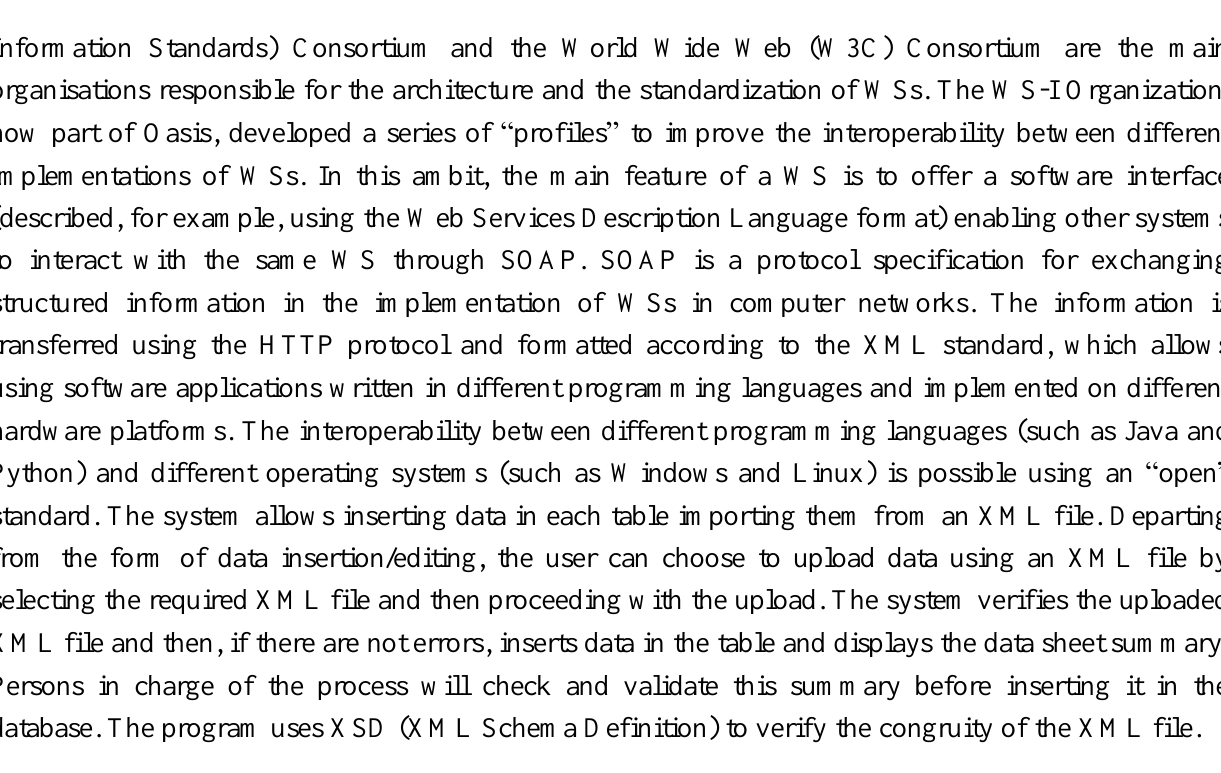
Figure 1. A snapshot of the SIT-REM graphical interface showing faunal-botanic data